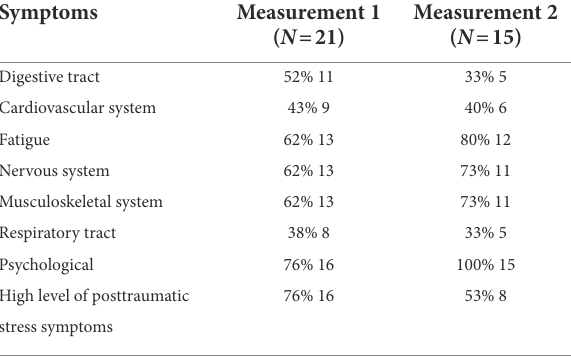
TABLE 2 Physical and psychological